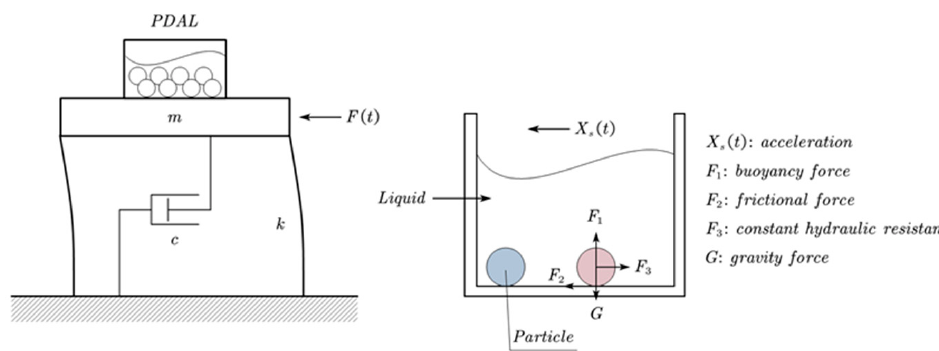
Figure 1. Structure of PDAL system.